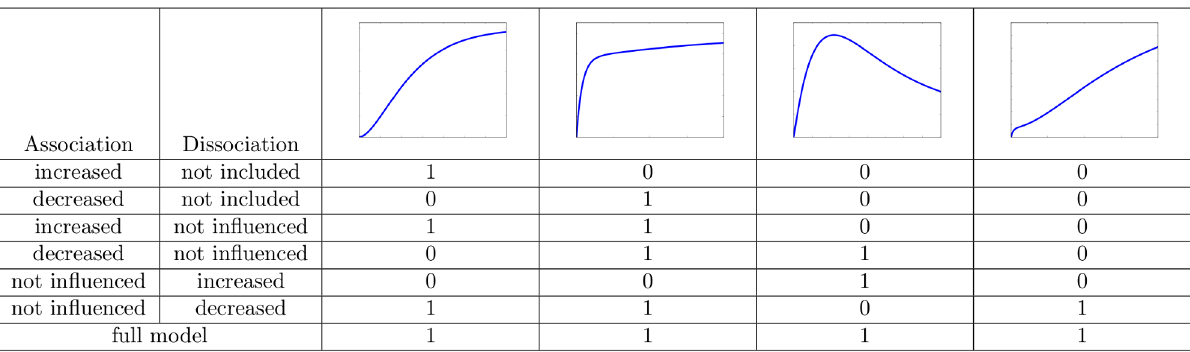
Figure 7. Comparison of the models.